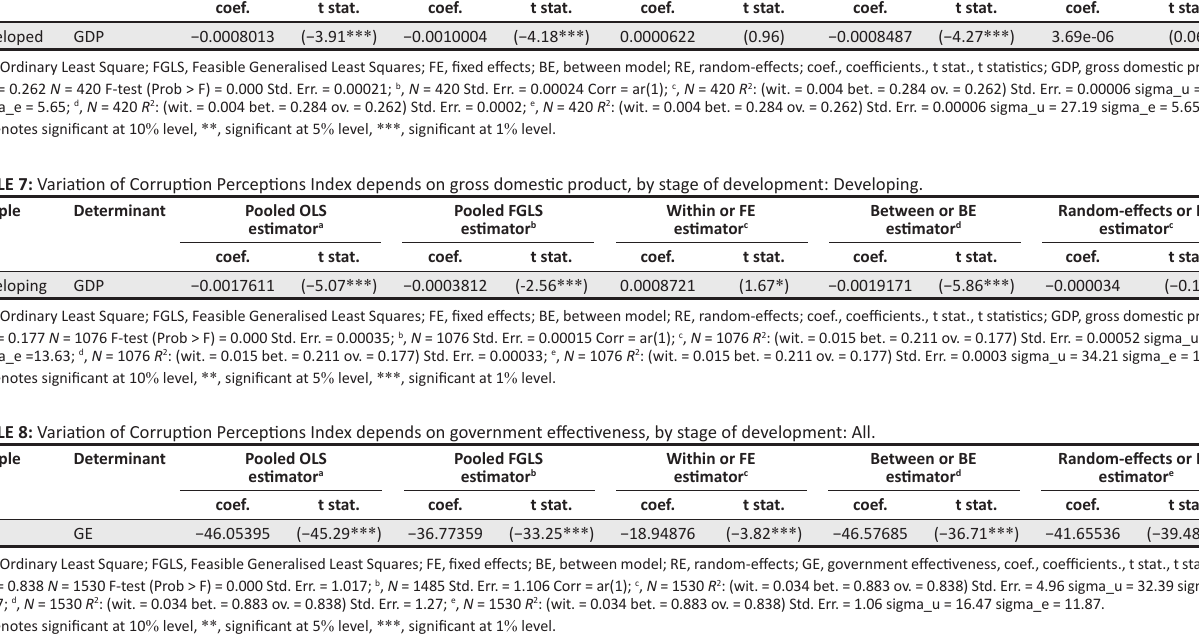
TABLE 6: Variation of Corruption Perceptions Index depends on gross domestic product, by stage of development: Developed.